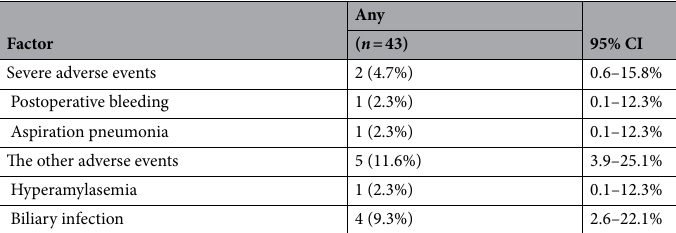
Table 2. Postoperative adverse events. A severe adverse event was defined as an event that resulted in death, the possibility of death, the disorders that interfere with daily life, the possibility of the disorders, the postponement of discharge for treatment, serious adverse events as described above, or the possibility of affecting future generations. CI confidence interval.